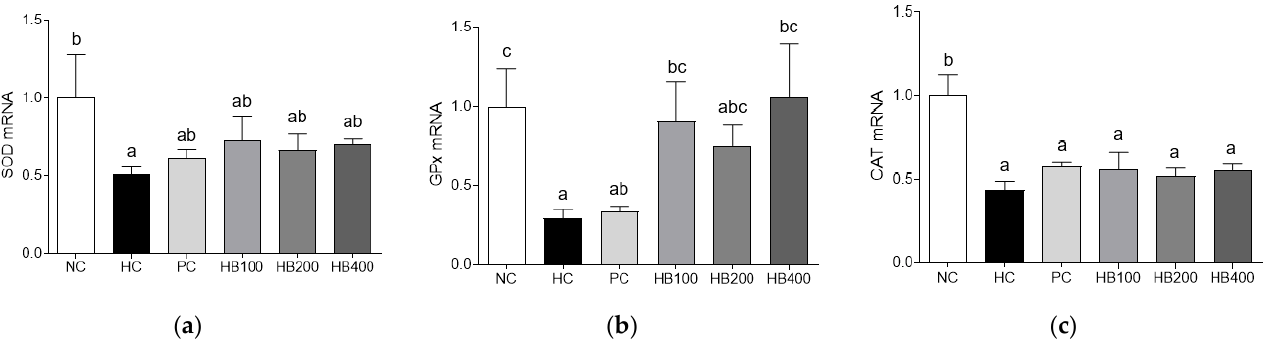
Figure 5. Effects of HB extract on mRNA expression levels of antioxidant enzymes. ( a ) SOD, superoxide dismutase; ( b ) GPX, glutathione peroxidase; and ( c ) CAT, catalase. Gene expressions were normalized to that of β -actin. NC, Normal diet Control; HC, HF diet control; PC, HF diet with orlistat at 20 mg/kg; HB100, HF diet with honeysuckle berry extract at 100 mg/kg; HB200, HF diet with honeysuckle berry extract at 200 mg/kg; HB400, HF diet with honeysuckle berry extract at 400 mg/kg. Data are presented as mean ± SD ( n = 8). Different letters indicate significant differences by one-way ANOVA ( p < 0.05) followed by Duncan’s multiple range tests.